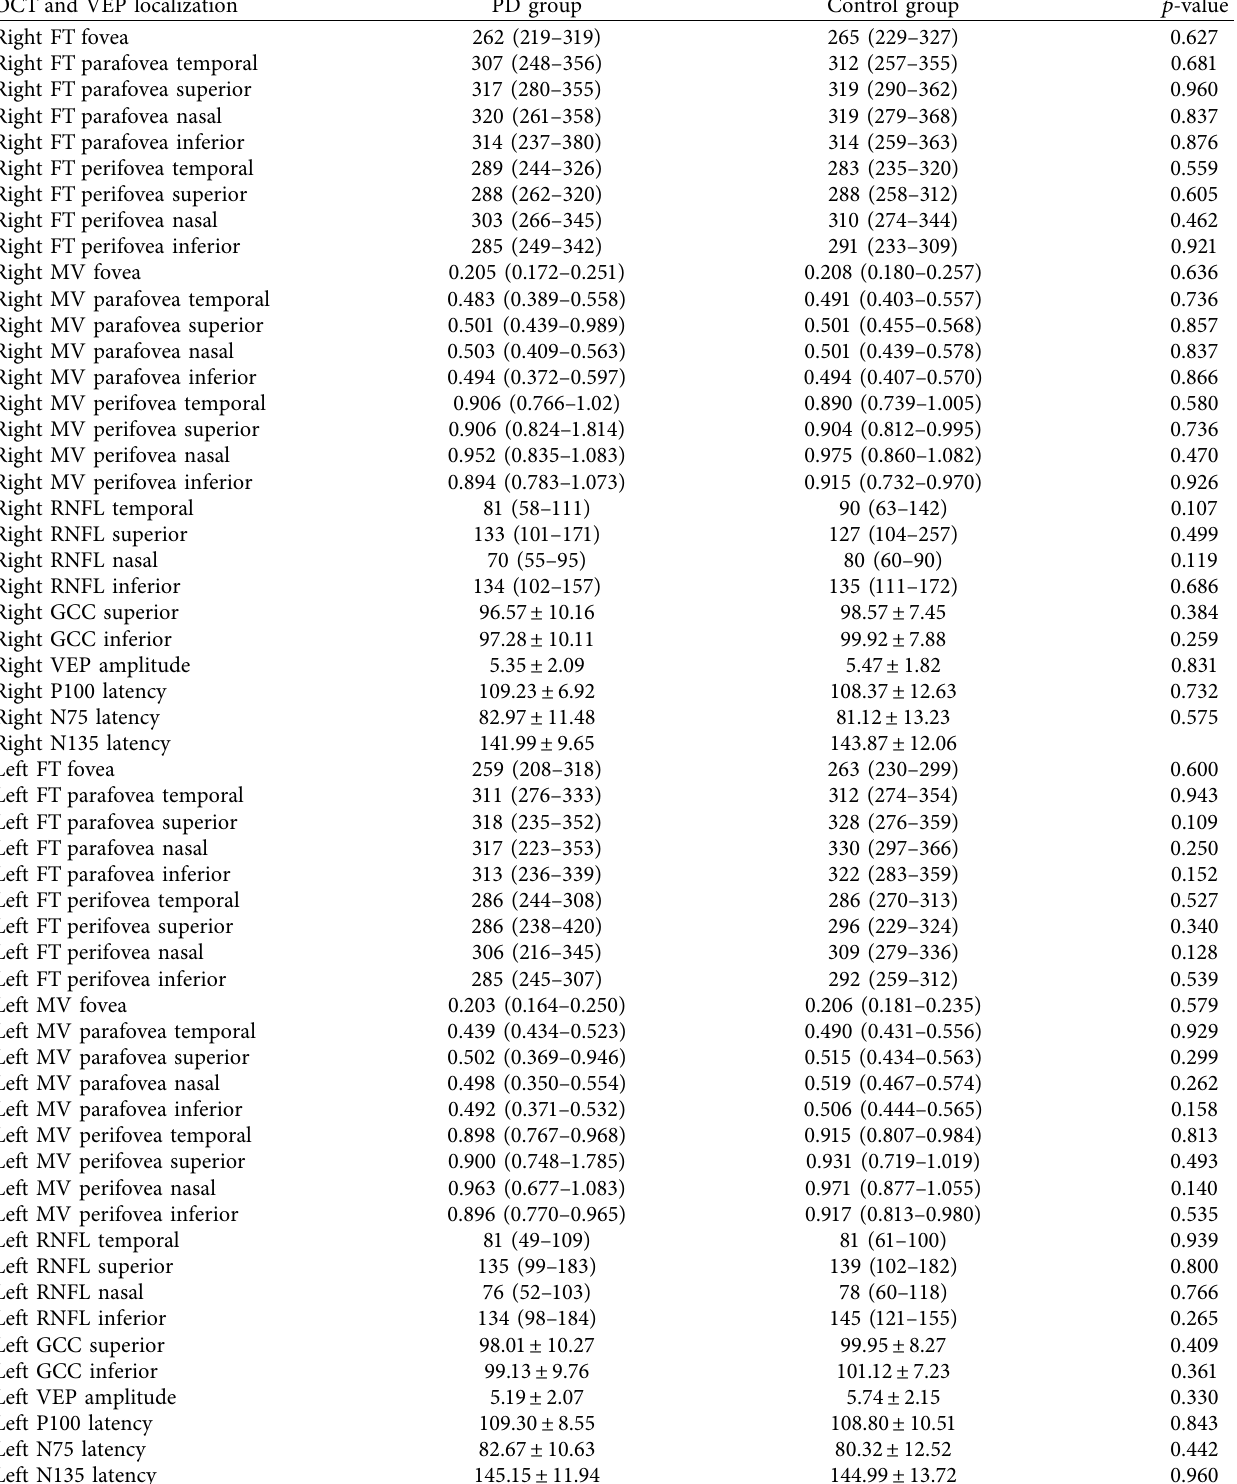
Table 3: OCT and VEP measurements between PD and control